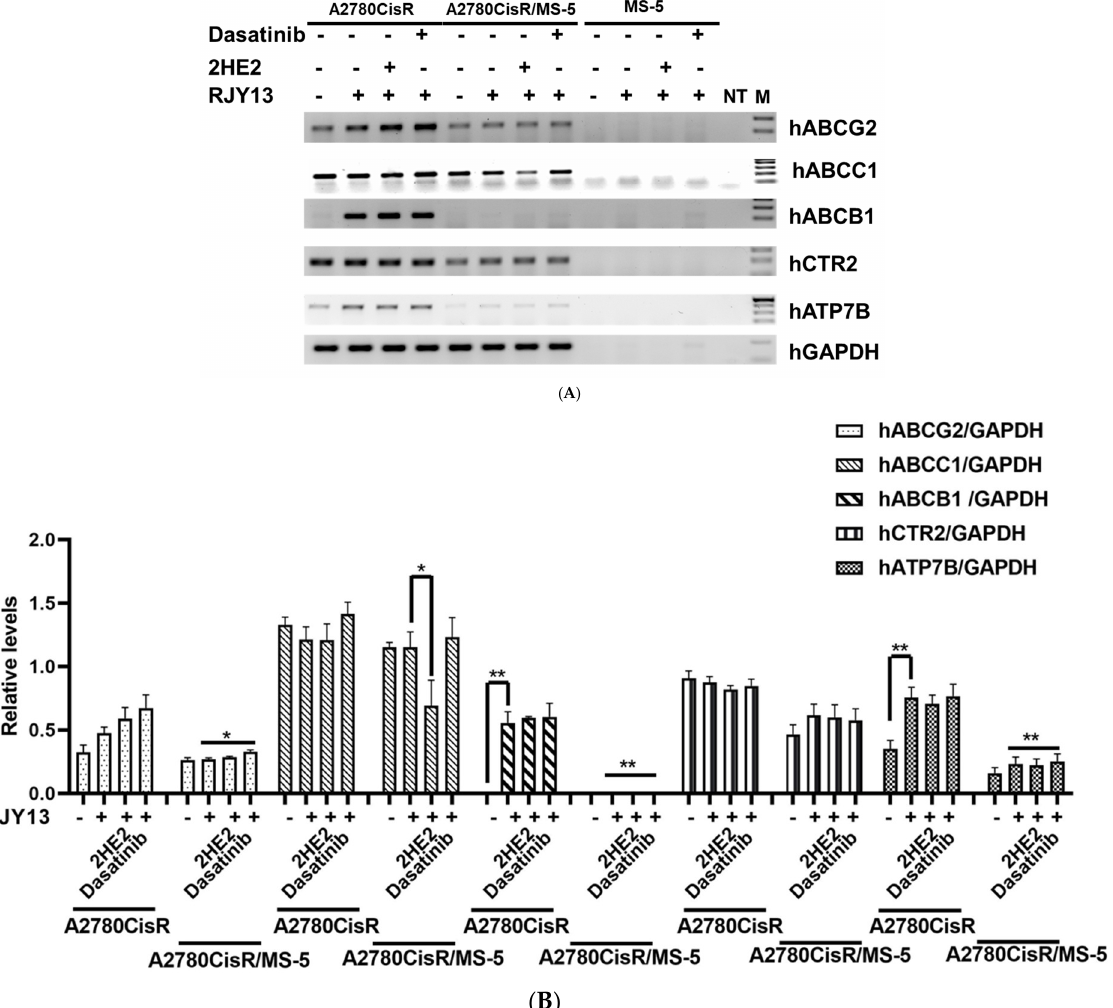
Figure 5. Effect of 2HE2 and dasatinib on expression levels of platinum transporters. ( A ) A2780CisR samples grown as monolayers or in direct co-culture with MS-5 were exposed to RJY13 (5 µ M) for 24 h in the presence of 2HE2 (10 μ M) and dasatinib (5 μ M) as indicated. Total RNA was isolated and RT-PCR was performed as described in materials and methods. In this experiment, primers for hABCG2, hABCC1, hABCB1, hCTR2, hATP7B, hGAPDH, and mGAPDH were used as described in materials and methods. PCR products were separated at 1% agarose. Molecular weight DNA is also shown (M) and a sample without any temple (NT) served as negative control. ( B ) Transporter levels relative to levels of GAPDH were calculated and blotted. PCR products us- ing mGAPDH are shown in Supplemental Figure S2. This experiment was repeated 3 times with similar results. * p < 0.05 and ** p < 0.01. 3. Discussion Previously, we demonstrated that direct co-culture of OC with MSC conferred chemoresistance to platinum compounds caused by the blocking of ERK1/2 activation [15]. Moreover, combining platinum with fisetin restored platinum drug sensitivity to OC cells co-cultured with MSC by re-activating ERK1/2 activity [15]. Direct co-cultures facilitate physical contact between the different cell types, which allows for communica- tion through their surface receptors. In this study, we examined the activity of additional modulators for their ability to restore platinum sensitivity in direct co-culture conditions of OC cells. Two modulators, 2-methoxyestradiol (2ME2) (Figure 1) and dasatinib (Figure 2) were successful in restoring partial platinum sensitivity to OC cells. Interestingly, the activity of 2-hydroxyestradiol (2HE2), a prodrug of 2ME2, was much more potent than the activity of 2ME2. 2ME2 is a non-active metabolite of estrogen that has been found to exhibit anticancer activities on several cancer cell lines [51,52]. 2HE2 exhibited very weak estrogenic activity [52] and was able to antagonize the estrogenic effect of estradiol [53]. 2HE2 is considered a prodrug of 2ME2 since the conversion of 2HE2 to 2ME2 is very ef- ficient [25]. During the last few decades, studies have demonstrated that 2ME2 is a potent anti-angiogenesis inhibitor [22,23] because it downregulates hypoxia-inducible factor-1 (HIF-1) at the posttranscriptional level and inhibits HIF-1-induced transcriptional acti- vation of VEGF expression [22]. Thus, we speculated that co-culture of OC with MSC might cause activation of HIF1 α , which, in turn, would promote platinum chemo- resistance [24,29]. Results demonstrated that no activation of HIF1 α was observed in co-culture conditions (Figure 1B). Furthermore, exposure of OC co-culture to BAY 87-2243, a selective hypoxia-inducible factor-1 (HIF-1) inhibitor [30], did not restore